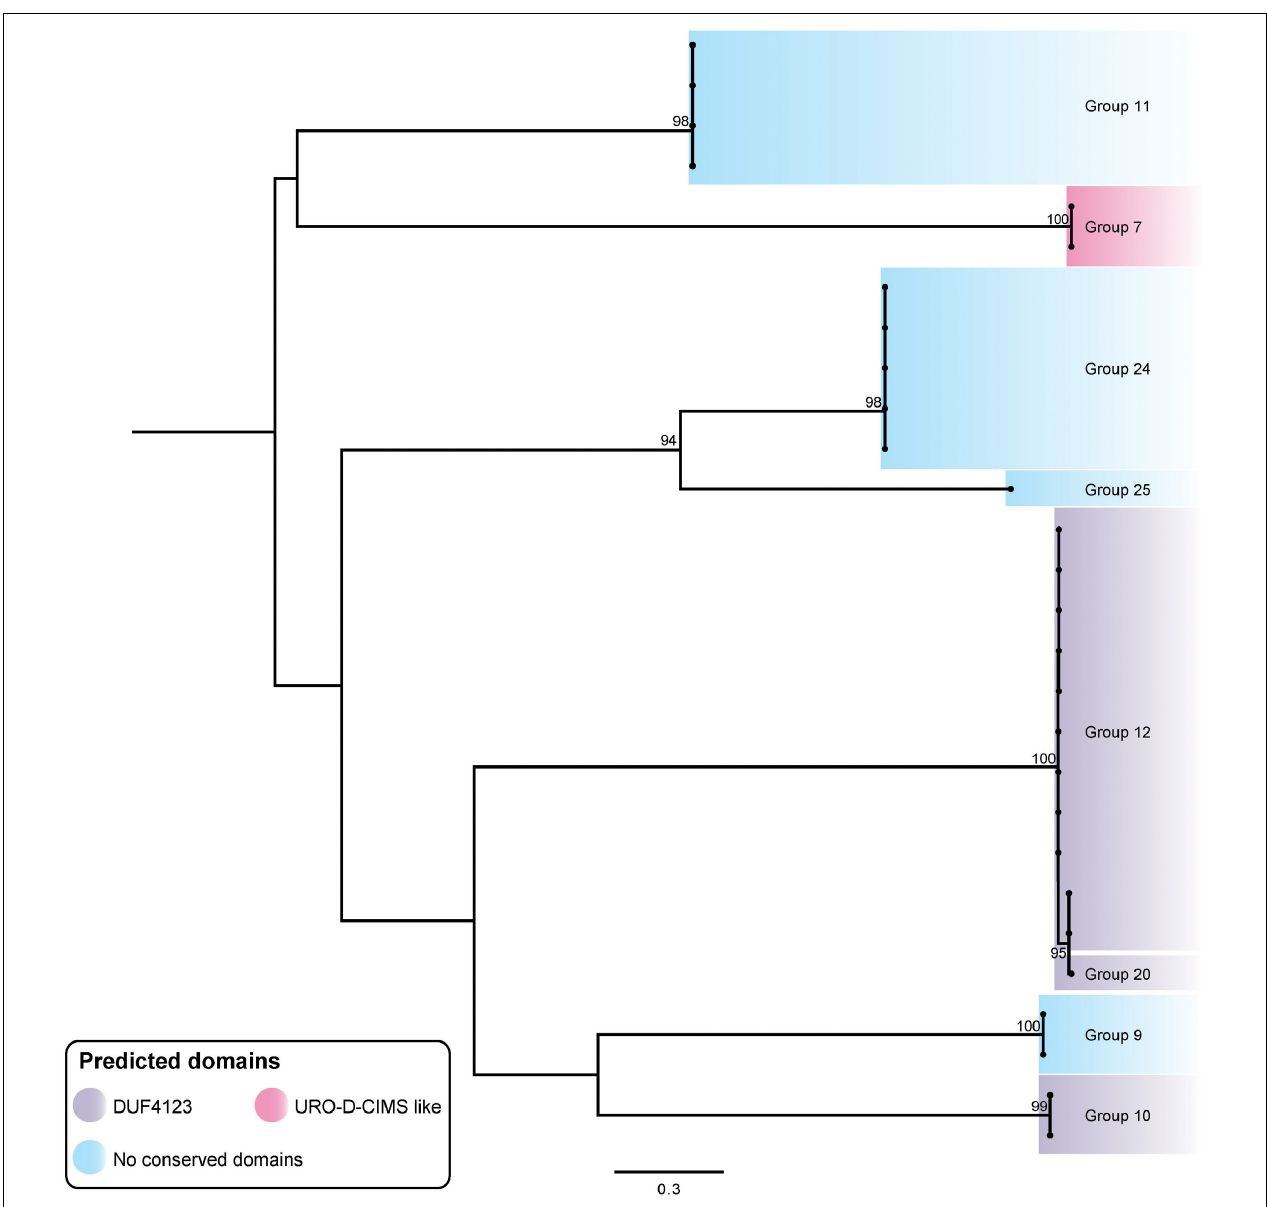
FIGURE 7 | ML phylogenetic tree of A. baumannii T6SS putative chaperone proteins. Branches have been named according to the effector loci to which the chaperone proteins correspond. The tree was generated from amino acid sequences using the general ‘variable time’ matrix model (VT + F). The scale bar represents the number of amino acid substitutions. Branch support values ≥ 70 (UFBoot) are shown at all major nodes ( Supplementary Files S3d , S4d